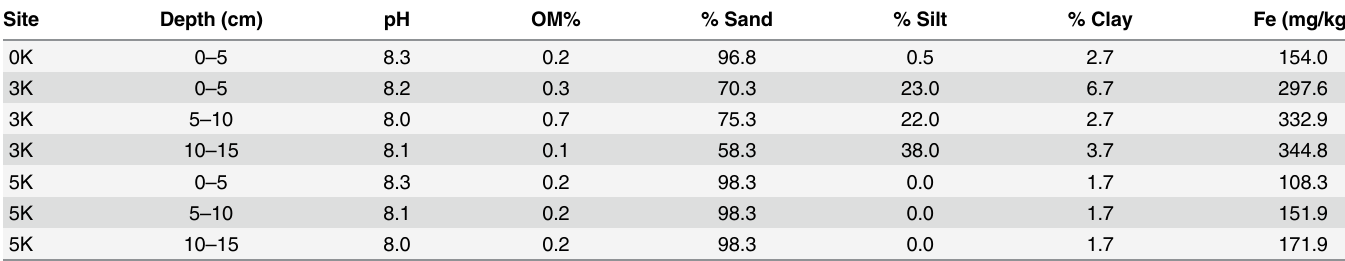
Table 4. Organic Mater, texture, pH, and iron at three depths in sediments from Sweetwater branch canal.